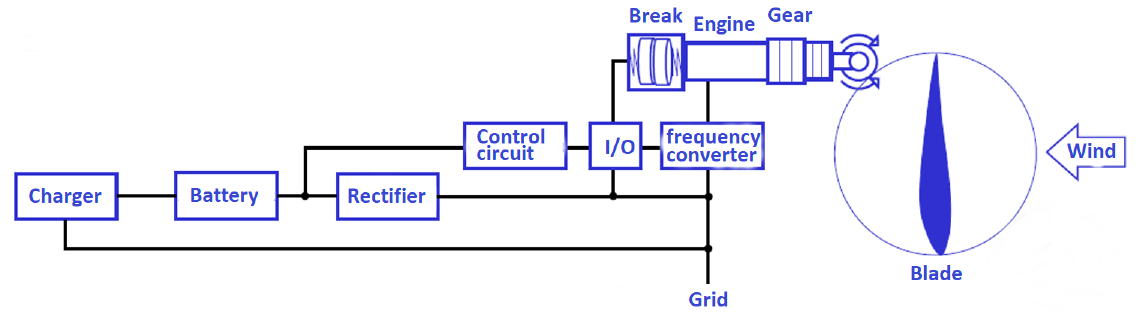
Figure 6. Construction of an electrical system for turning blades [27] .